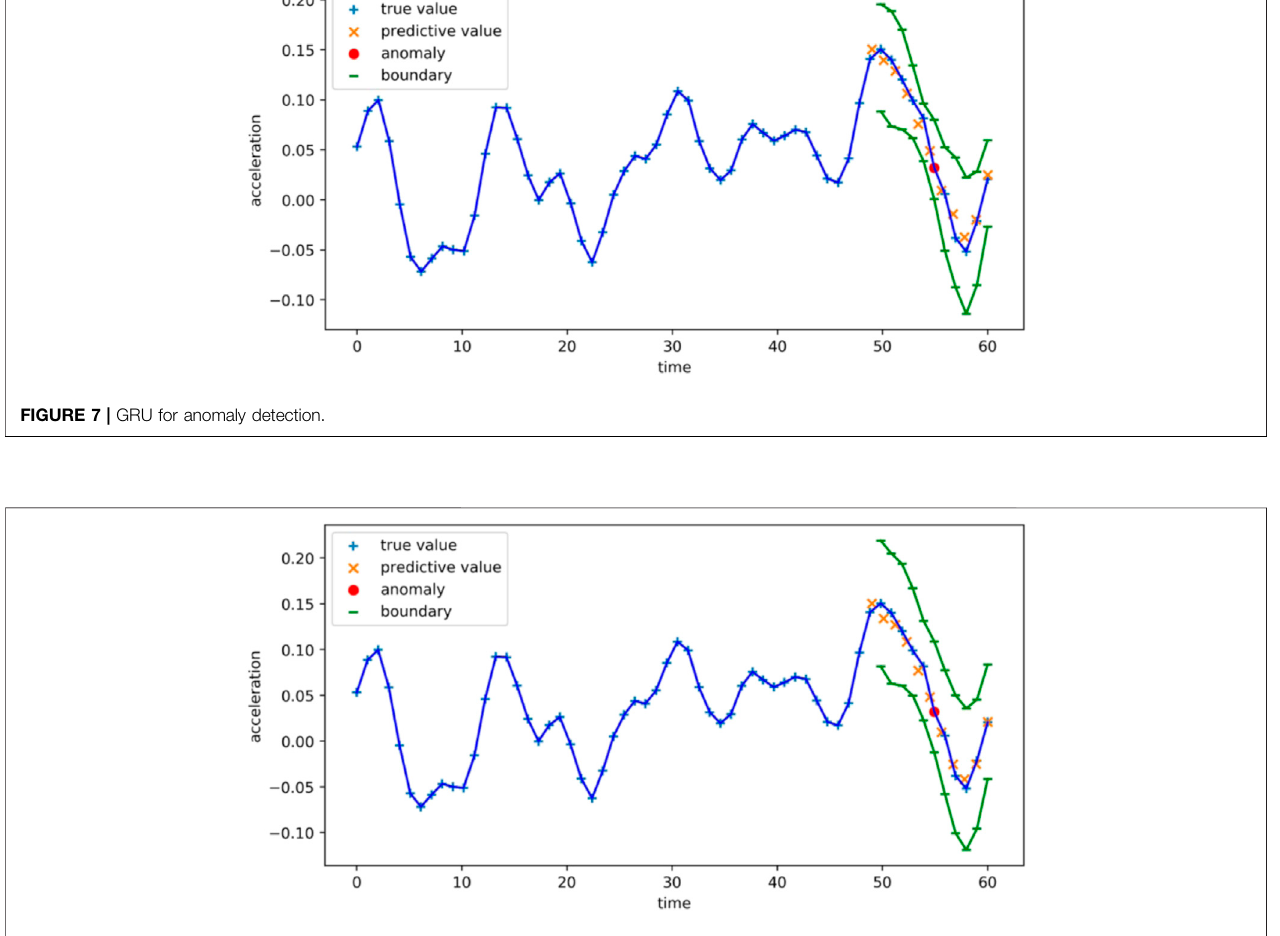
FIGURE 8 | BiLSTM for anomaly